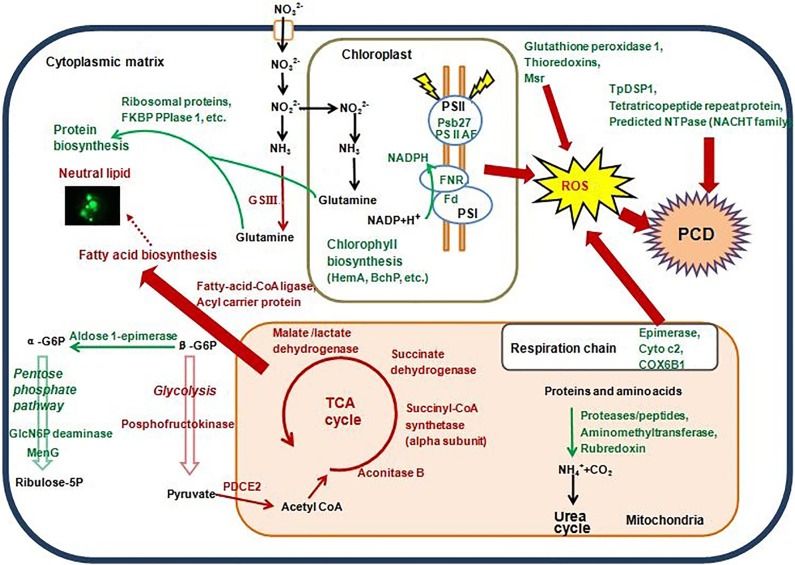
Hypothetical cellular pathways and processes in the diatom T. pseudonana under N-limited growth conditions.Red words and arrows represent proteins with increased abundance and enhanced pathways, respectively. Green words and arrows represent proteins with decreased abundance and inhibited pathways, respectively. Fluorescence micrograph shows the neutral lipid accumulation in N-limited cells. HemA: porphobilinogen deaminase; BchP: dehydrogenases (flavoproteins); Psb27: photosystem II Psb27 protein; PSII AF: uncharacterized protein related to plant photosystem II stability/assembly factor; Fd: ferredoxin; FNR: ferredoxin-NADP reductase; Cyto c2: cytochrome c2; COX6B1: cytochrome c oxidase subunit 6B1; ROS: reactive oxygen species; Msr: peptide methionine sulfoxide reductase; PCD: programmed cell death; TpDSP: T. pseudonana death-specific protein; FKBP PPIase 1: FKBP-type peptidyl-prolyl cis–trans isomerase 1; GlcN6P deaminase: glucosamine-6-phosphate isomerase; MenG: demethylmenaquinone methyltransferase; PDCE2: pyruvate/2-oxoglutarate dehydrogenase complex, dihydrolipoamide acyltransferase (E2) component; TCA: tricarboxylic acid cycle; GSIII: uncharacterized protein related to glutamine synthetase (GSIII).